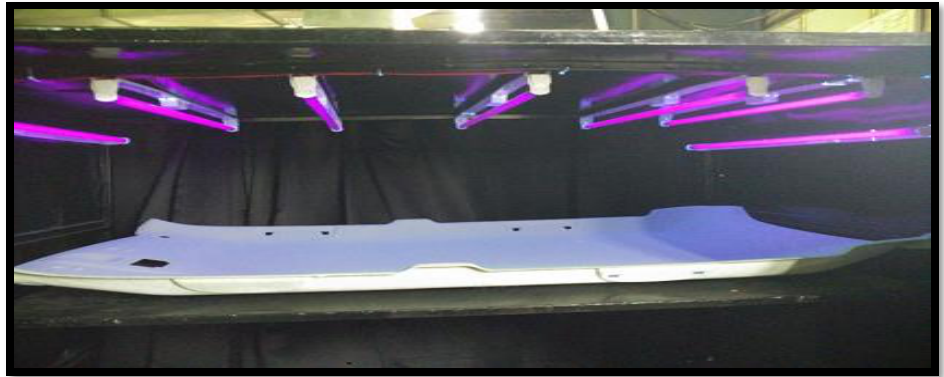
Figure 3. UV rays detection set up under